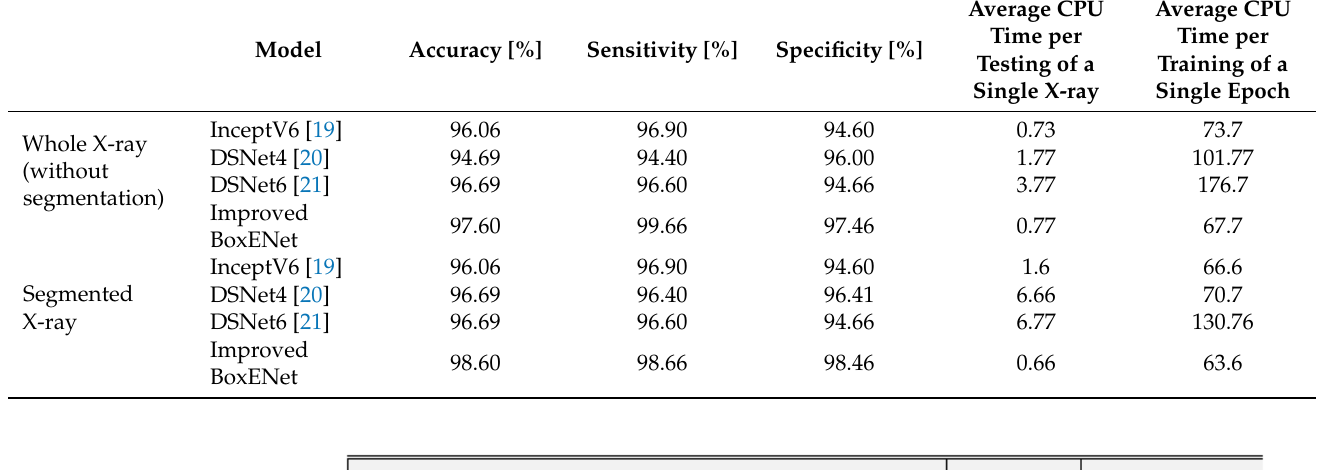
Table 9. Comparison of various CNNs for pneumonia multi-classification with whole and segmented X-rays.